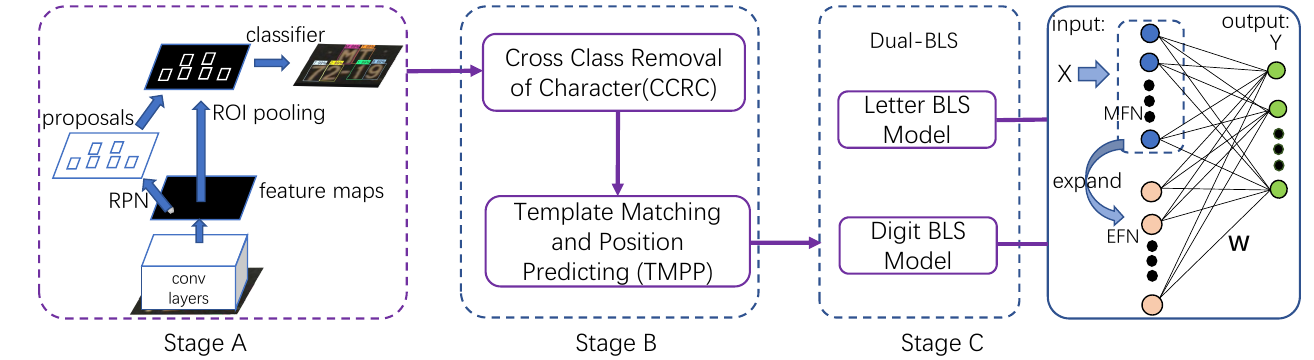
Figure 3. The flowchart of the proposed method. It includes three stages: stage A is employed to generated ROIs, stage B is designed to remove cross class and predict positions of missing characters, and stage C is designed to handle the problem of recognition